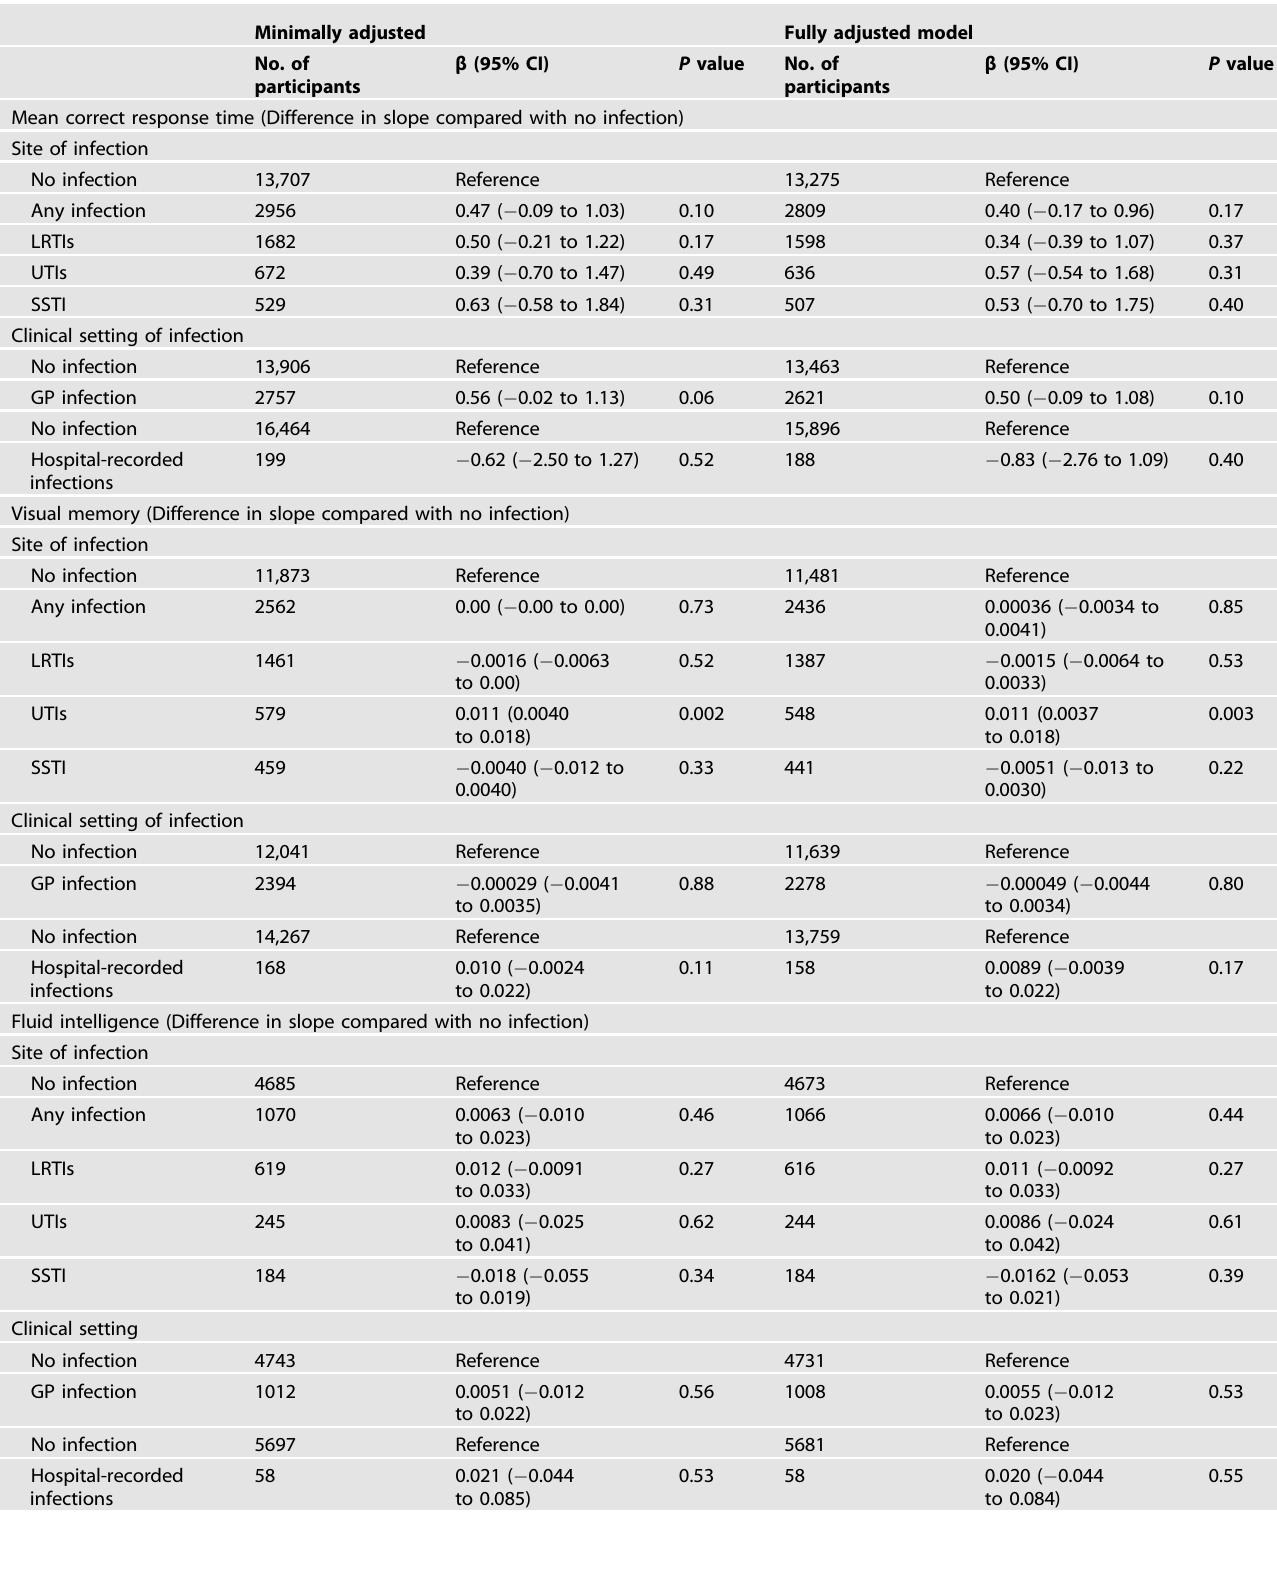
Table 3. Association of site and clinical setting of common infections with cognitive